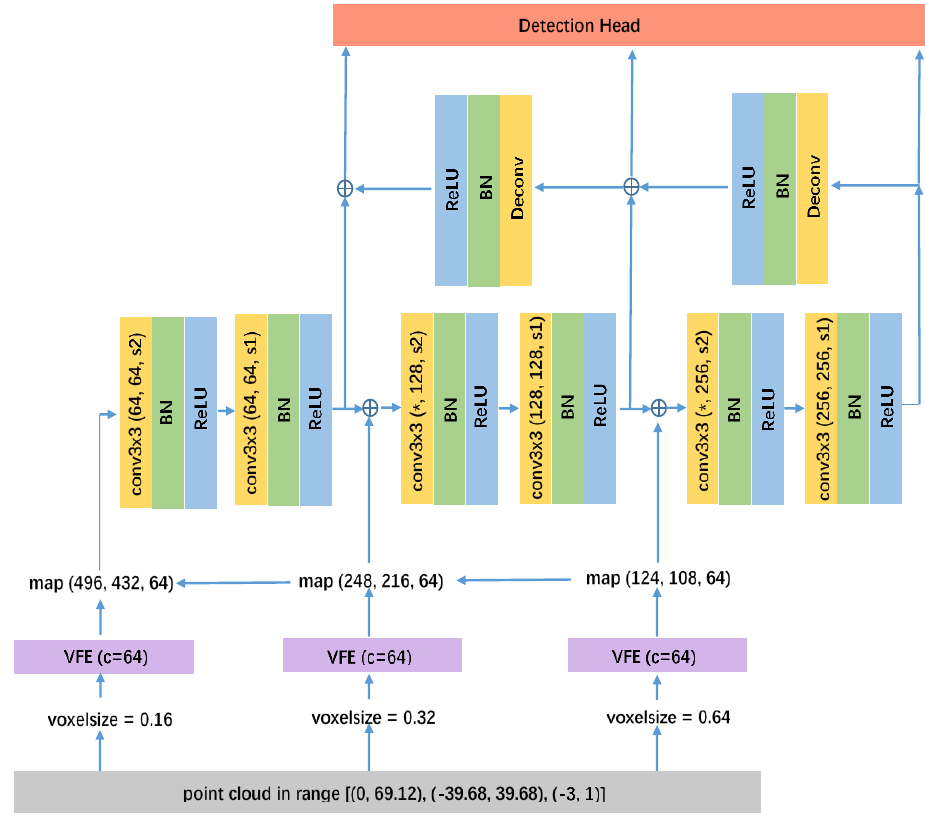
Figure 3. The detailed structure for